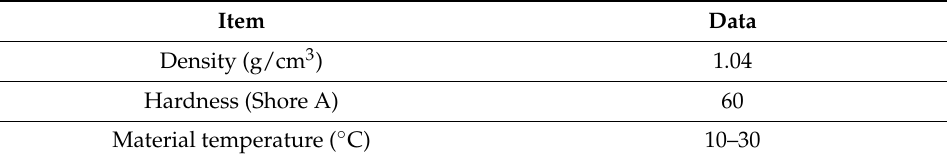
Table 3. Properties of the molding